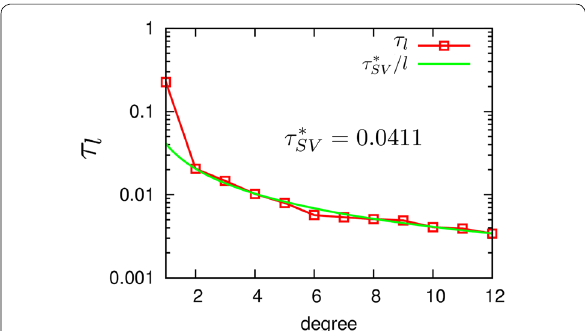
Fig. 2 Secular variation time scale of our dynamo model. The time scale of secular variation for each spherical harmonic degree τ l is 2 . The resulting τ fitted by τ ∗ SV / l for l ∗ SV is 0.0411, which was utilized ≥ to scale the dimensionless numerical dynamo